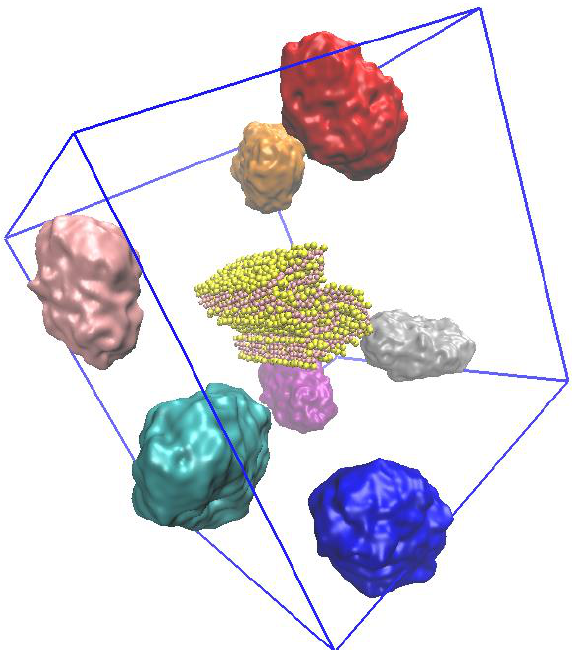
showing the protein fibril in the center and the initial positions of the NPs. Water and ions are not Figure 8. Fibril – NP molecular models. Overlap of the eight initial configurations for PE models, 332